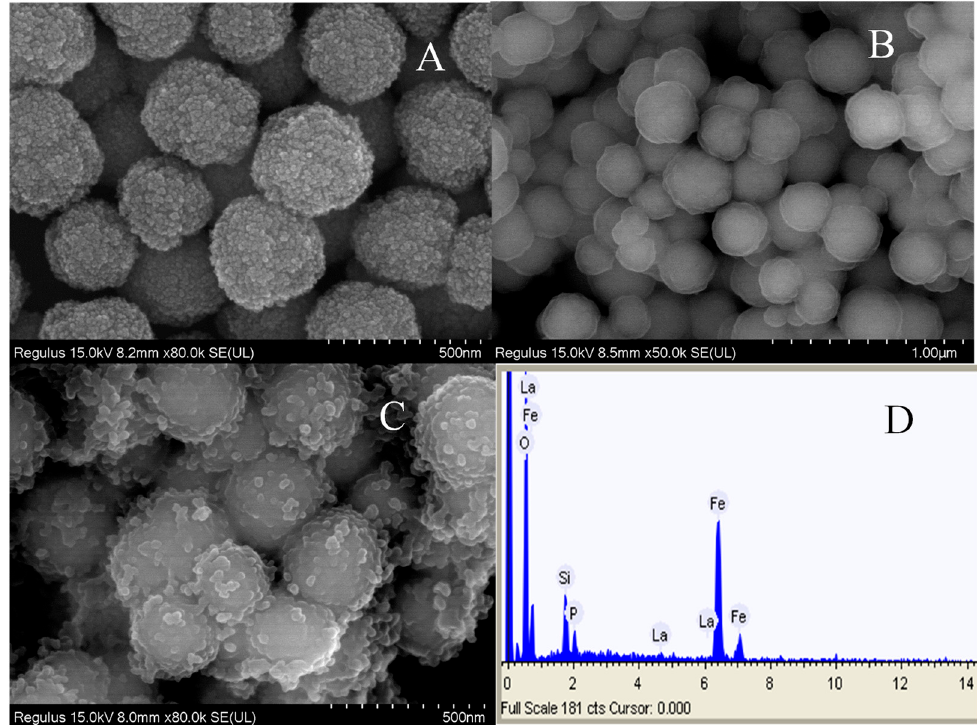
Figure 3. SEM images of ( A ) Fe 3 O 4 , ( B ) Fe 3 O 4 @SiO 2 , ( C ) Fe 3 O 4 @La(OH) 3 and ( D ) elemental analysis of Fe 3 O 4 @La(OH) 3 .